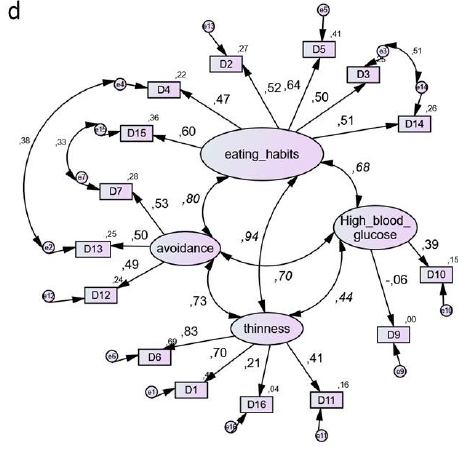
Figure 1. Use of the Diabetes Eating Problem Survey-Revised (DEPS-R) in a Greek adult population with type 1 diabetes mellitus: comparison between four-factor models. ( a ) Model 1. (The most parsimonious) Factors: (1) DEPS-R one single factor. χ 2 = 102.1, df = 87, χ 2 /df = 1.17, CFI = 0.954, TLI = 0.944, RMSEA = 0.041, AIC = 168, ECVI = 1.65, ECVI LO-HI 90 = 1.53–1.97. ( b ) Model 2. Factors: (1) Eating Habits, (2) High Blood Glucose. χ 2 = 102.1, df = 86, χ 2 /df = 1.18, CFI = 0.951, TLI = 0.940, RMSEA = 0.043, AIC = 170, ECVI = 1.67, ECVI LO-HI 90 = 1.51–1.96. ( c ) Model 3. Factors: (1) Eating Habits, (2) High Blood Glucose, (3) Thinness. χ 2 = 99.7, df = 84, χ 2 /df = 1.19, CFI = 0.952, TLI = 0.940, RMSEA = 0.043, AIC = 171, ECVI = 1.68, ECVI LO-HI 90 = 1.53–1.97. ( d ) Model 4. Factors: (1) Eating Habits, (2) High Blood Glucose, (3) Thinness, (4) Avoidance. χ 2 = 96.1, df = 81, χ 2 /df = 1.19, CFI = 0.954, TLI = 0.940, RMSEA = 0.043, AIC = 174, ECVI = 1.71, ECVI LO-HI 90 = 1.56–1.99. Note: Coefficients in curved lines indicate correlations. Coefficients in straight lines indicate standardized regression weights. The models are output of AMOS statistical software, where comma is used by default as a decimal separator. The numbers following commas indicate decimal points.